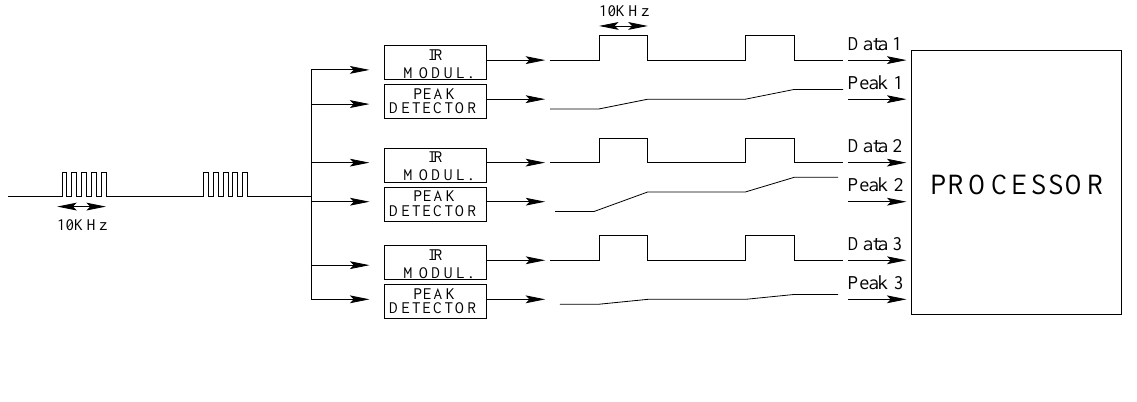
Figure 9. Reception module